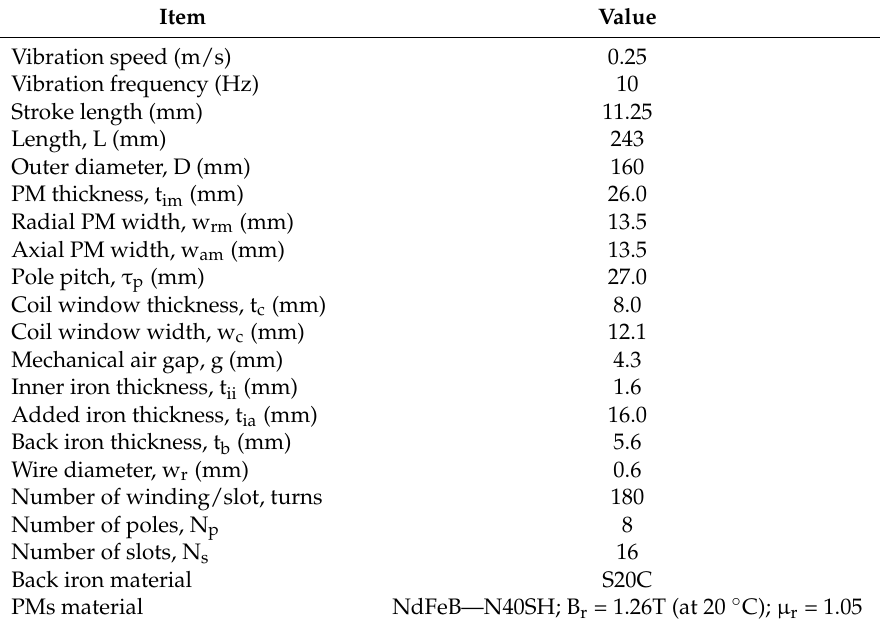
Table 1. Design specifications of the tubular machine with classical Halbach array.